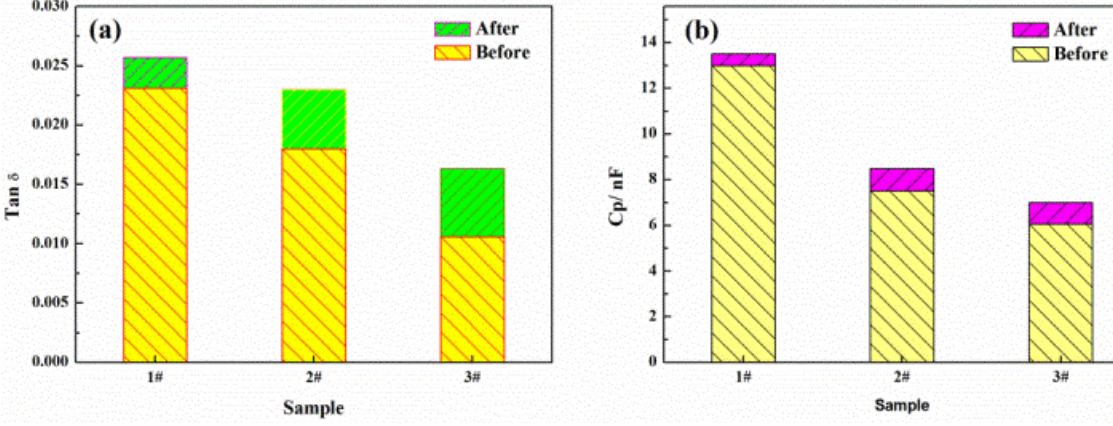
Figure 3: Variations of (a) C p and (b) tan δ of these three ceramics before and after electric degradation